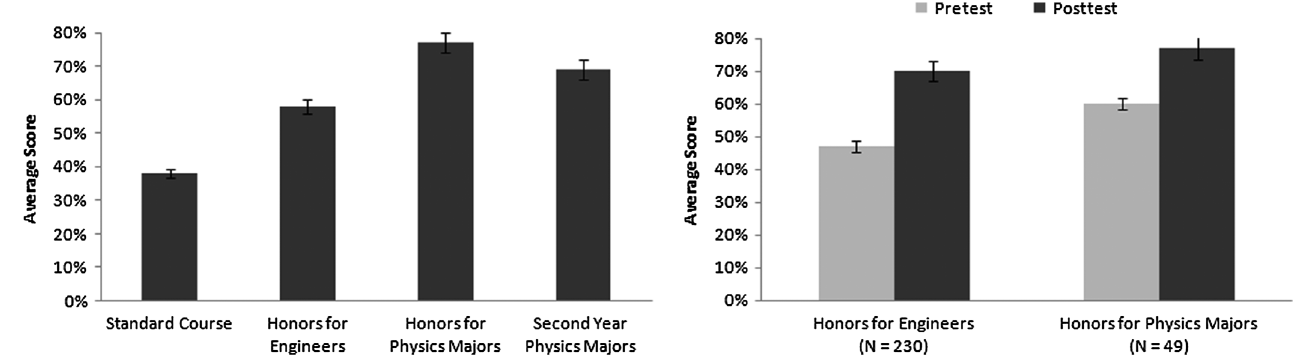
FIG. 1. Summary of FVA scores. The graph on the left shows a trend of increasing post-test score with increasing class level for four different calculus mechanics courses ranging from first-year introductory to second-year physics majors. The graph on the right shows pre- and post-test scores for the two different honors introductory mechanics courses.